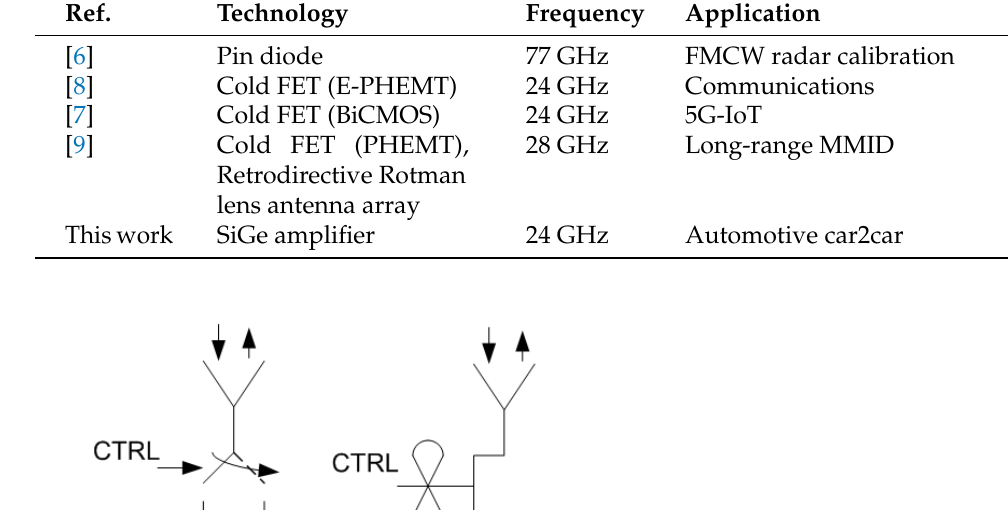
Table 1. Millimeter band backscatters. Ref.